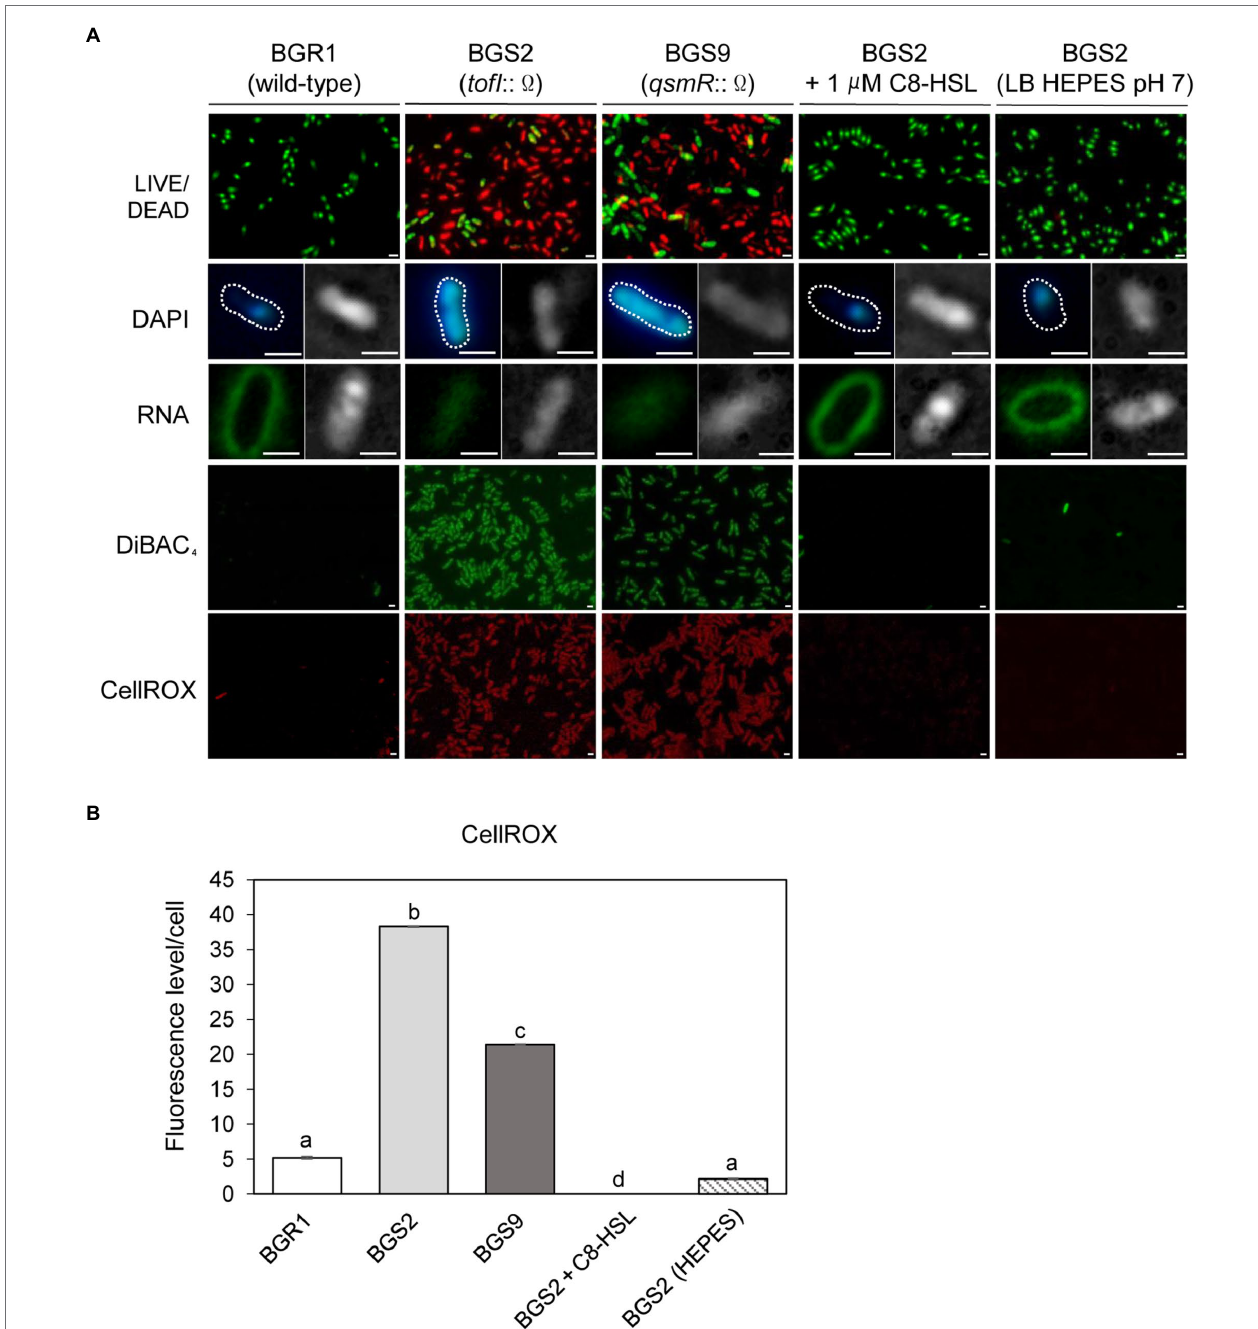
FIGURE 2 | Fluorescence staining of wild-type BGR1 and QS mutants after 24 h in LB broth at 37 ° C. (A) Cell viability was assayed via LIVE/DEAD BacLight ™ cell staining. Live and dead cells were detected as green and red fluorescence, respectively. DNA was stained with 40,6-diamidino-2- phenylindole dihydrochloride (DAPI) and RNA was stained with SYTO ™ RNASelect ™ (Rows 2 and 3). Differential interference contrast (DIC) microscopy (right) images and merged DIC/fluorescence images (left) with DAPI or SYTO ™ RNASelect ™ staining are depicted. Wild-type BGR1 and the QS mutants were treated with DiBAC 4 (3) to observe membrane depolarization and CellROX to measure cellular reactive oxygen species (ROS) levels. BGS2 (BGR1 tofI :: Ω ) cells were supplemented with 1 μ M of C8-HSL and 100 mM 4-(2-hydroxyethyl) piperazin-1 ethanesulfonic acid (HEPES; pH 7). Scale bars, 1 μ m. (B) Quantitative imaging analysis of ROS levels based on CellROX staining intensity. The fluorescence intensity was analyzed using ImageJ version 1.53a software (NIH). Data are mean ± SE of triplicate experiments. The letters (a, b, c, and d) above each mean represent groupings of statistical significance based on ANOVA/Tukey’s correction for multiple comparisons. A value of p < 0.05 represents significant differences among